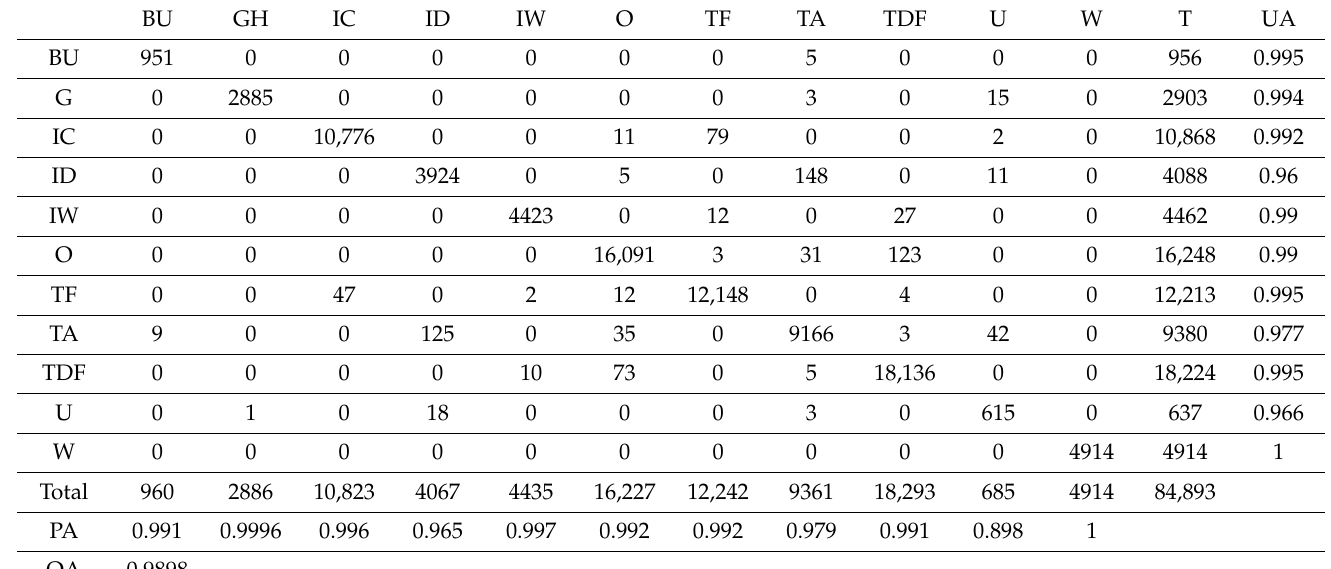
Table A2. Error matrix for accuracy assessment of the classification in 2019 using random forest.